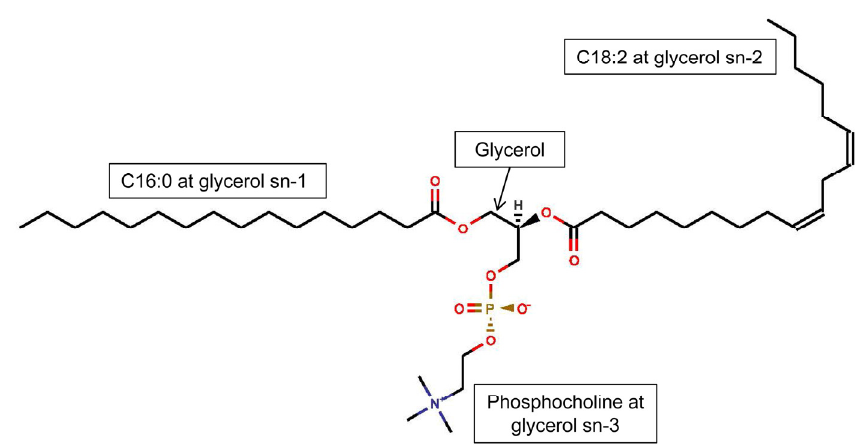
Figure 1. Phospholipids consist of glycerol, usually esterified to a saturated long chain fatty acid at sn-1 and to an unsaturated long chain fatty acid at sn-2, and to a phosphorylated head group at sn-3. This example is 1-hexadecanoyl-2-(9 Z ,12 Z -octadecadienoyl)- sn -